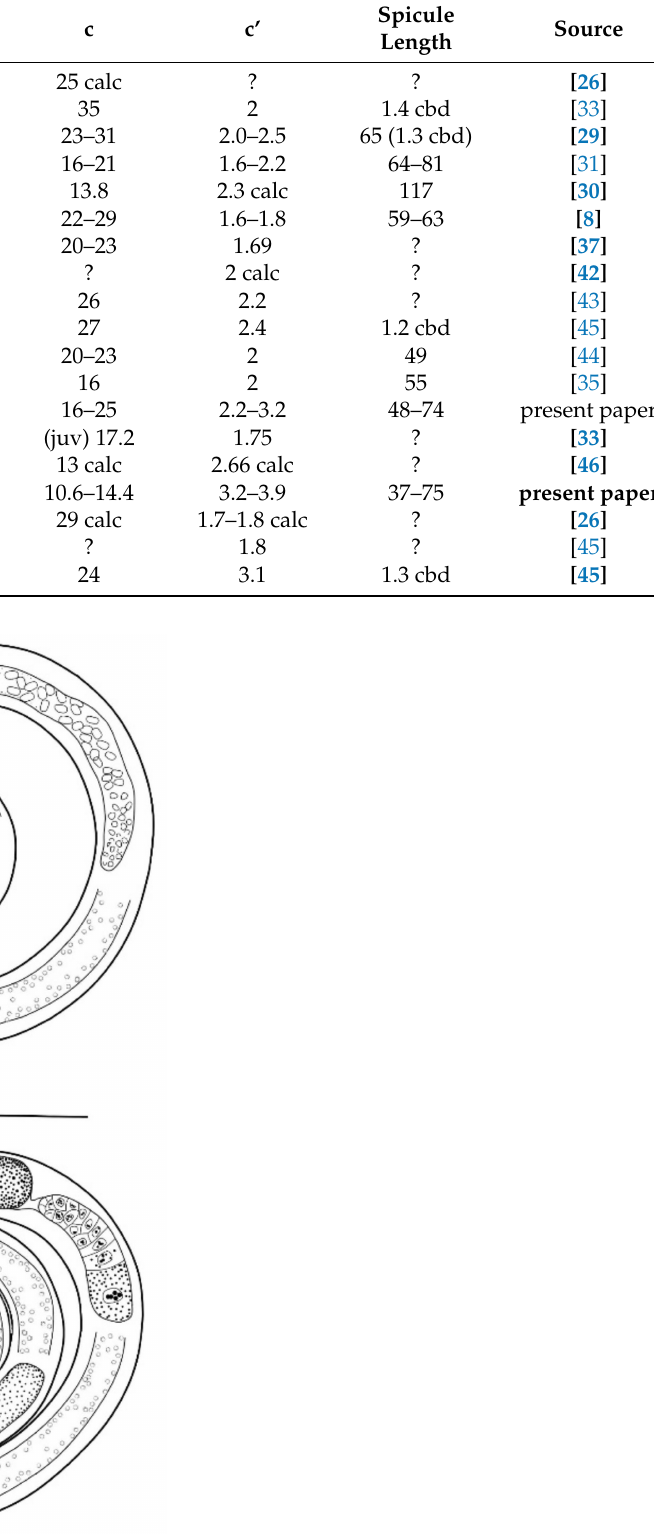
Table 6. Morphometrical comparison of males of valid Acanthopharynx species (data rounded, names and sources of original diagnoses in bold). “?”means no data.